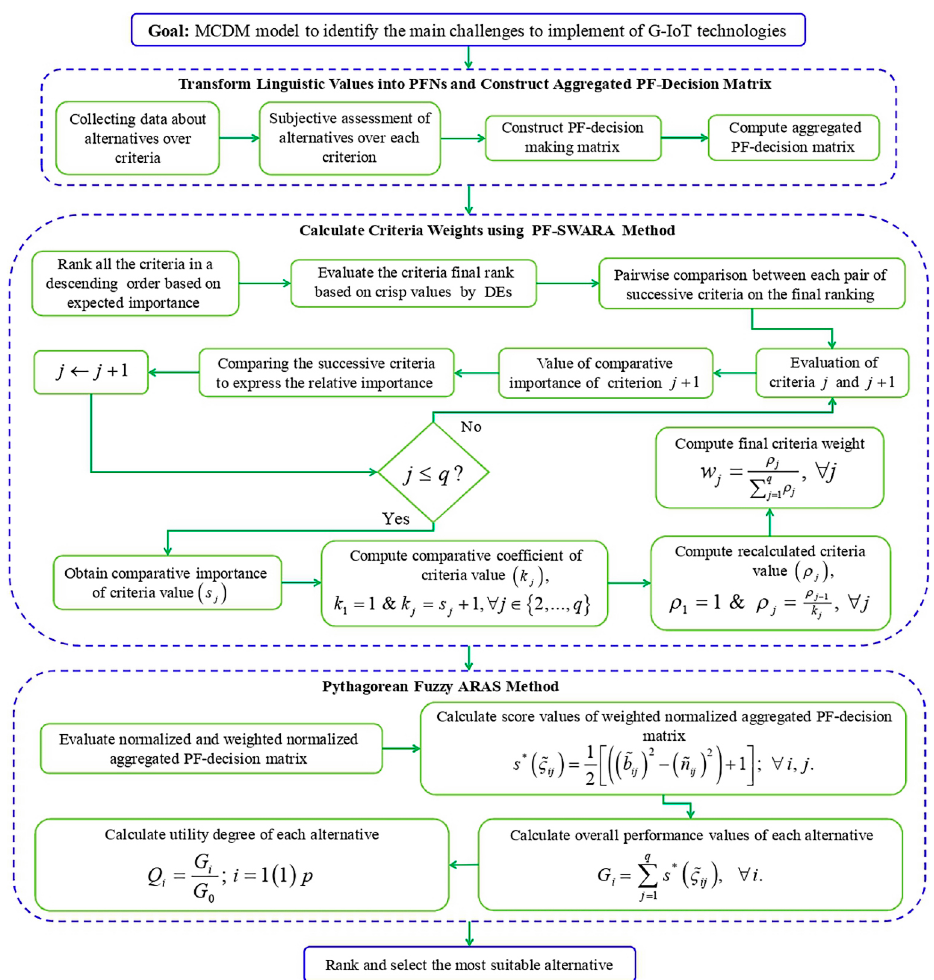
Figure 2. Diagram of the PF-SWARA-ARAS model to implement of G-IoT